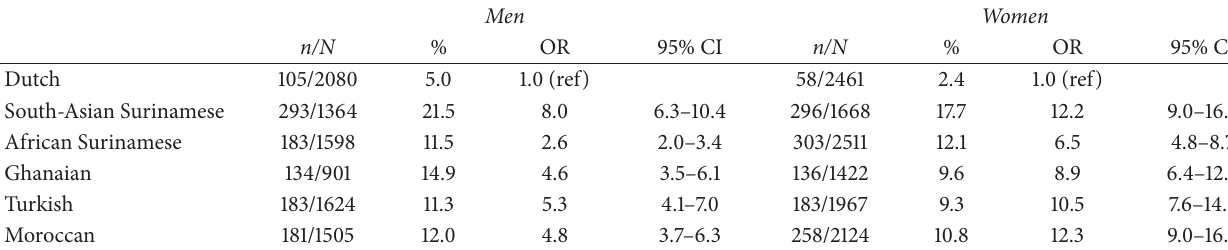
Table 2: Ethnic differences in the prevalence of diabetes † by sex, adjusted for age.